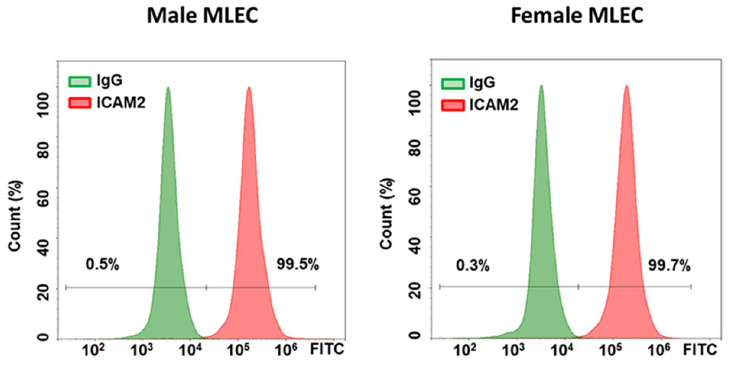
Fig 1. Analysis of isolated male and female MLEC. The percentage of ICAM2 positive male and female MLEC were analyzed. Both sexes showed a comparable and highly homogenous population of MLEC. Representative data out of four independent cell isolations (N = 5–7 per gender per isolation) from mice obtained from different litters.